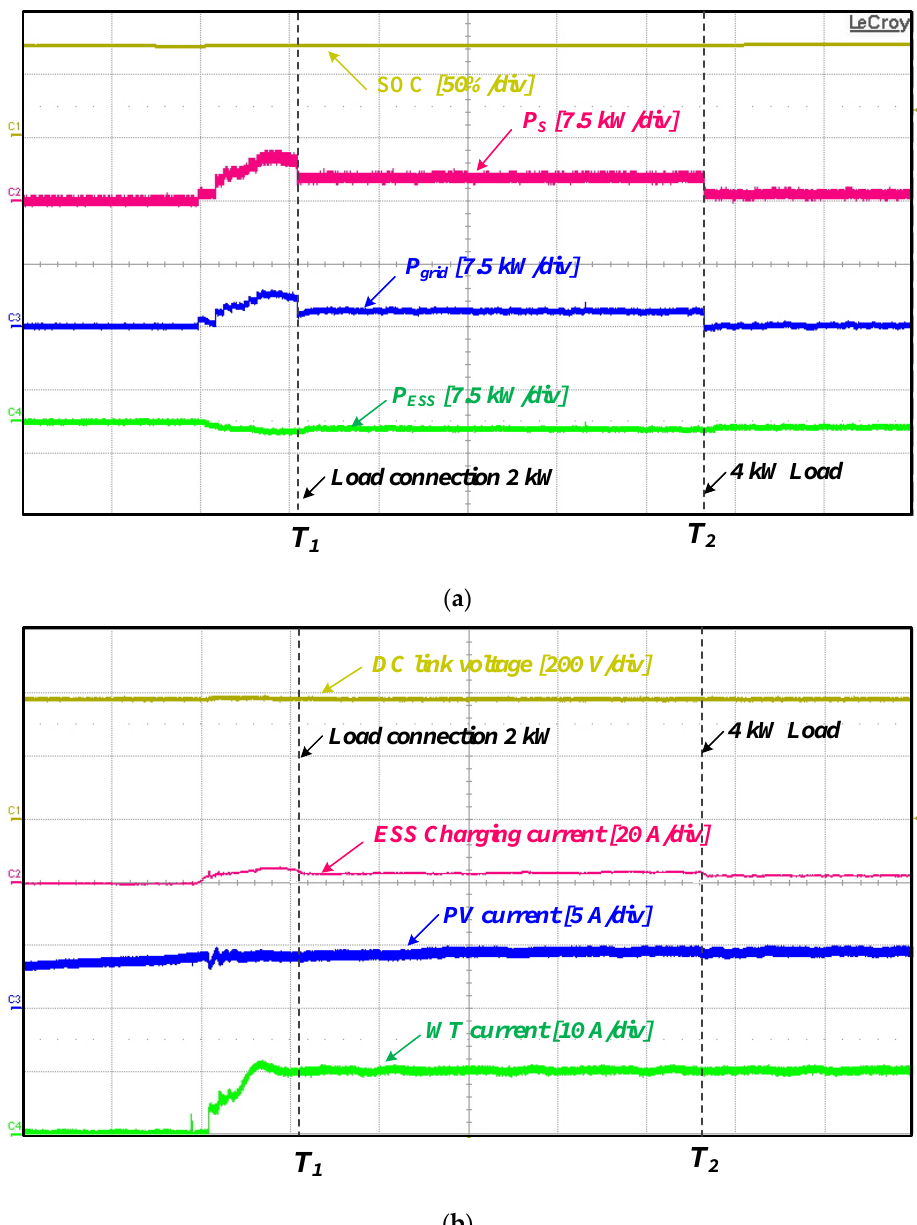
Figure 21. Experiment waveforms of operation mode 2 ( a ) ANN input/output data waveform, ( b ) Voltage and current waveforms in major parts.